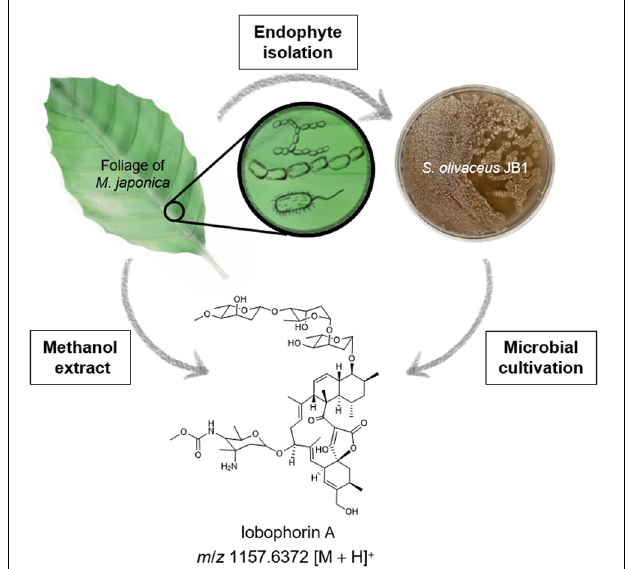
FIGURE 1 | Schematic overview of isolation of endophytes associated with M . japonica and lobophorin detection from the plant material and the endophytic bacterium S . olivaceus JB1. The bacterial strain S. olivaceus JB1 was isolated from the sterilized lateral vein of M. japonica, S. olivaceus JB1 was cultured in modified K liquid medium for 6 days, and liquid culture broth was extracted by using ethyl acetate/water layer separation. The organic phase was concentrated in vacuo . The foliage and petioles of M. japonica were subjected to extraction with methanol. The extracts were analyzed using Q-TOF-MS, and notably, lobophorin A ( m / z 1157.6372 [M + H] + ) was detected from both the S. olivaceus JB1 extract and M.